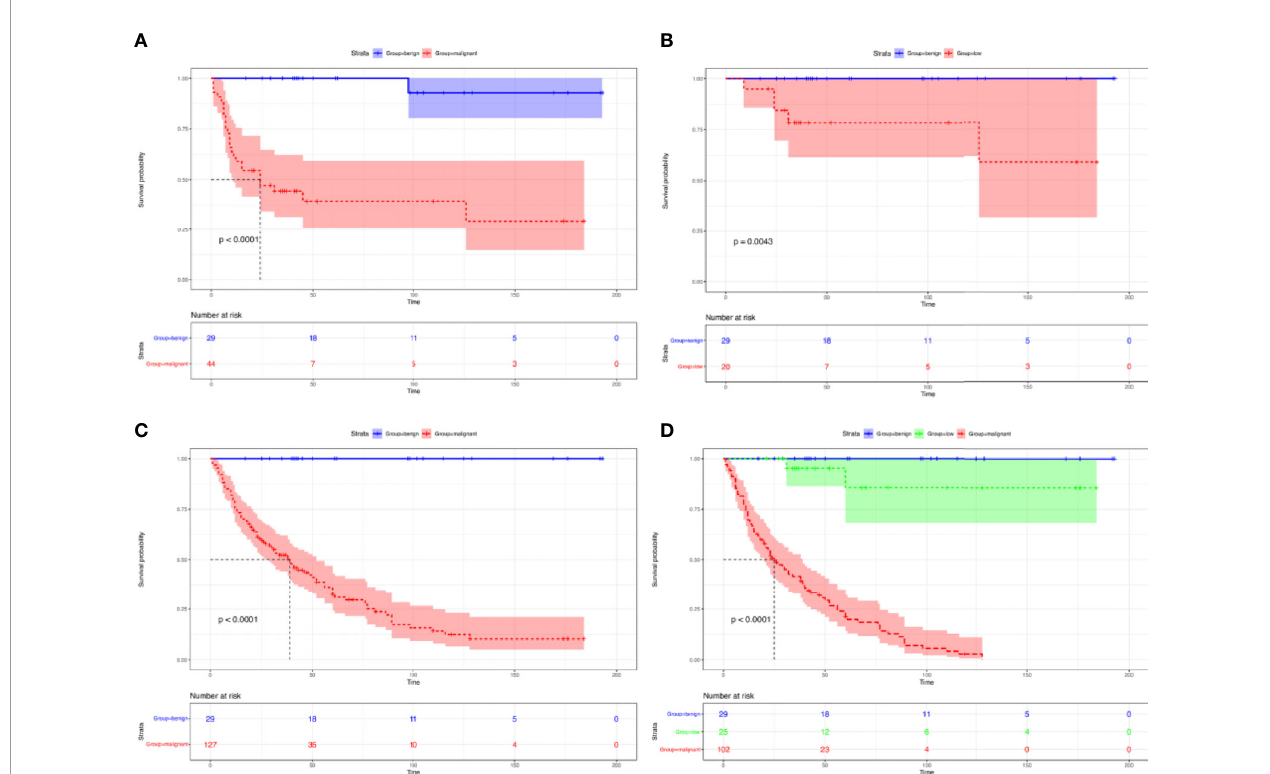
FIGURE 3 | Survival of patients with GMTs who underwent complete resection. Recurrence-free survival in patients with GMTs who underwent complete resection: benign GMTs versus malignant GMTs (A) , and benign GMTs versus low-grade malignant GMTs (B) . Overall survival in patients with GMTs >10 cm who underwent complete resection: benign GMTs versus malignant GMTs (C) , and among benign GMTs and low-grade malignant and malignant GMTs (D)